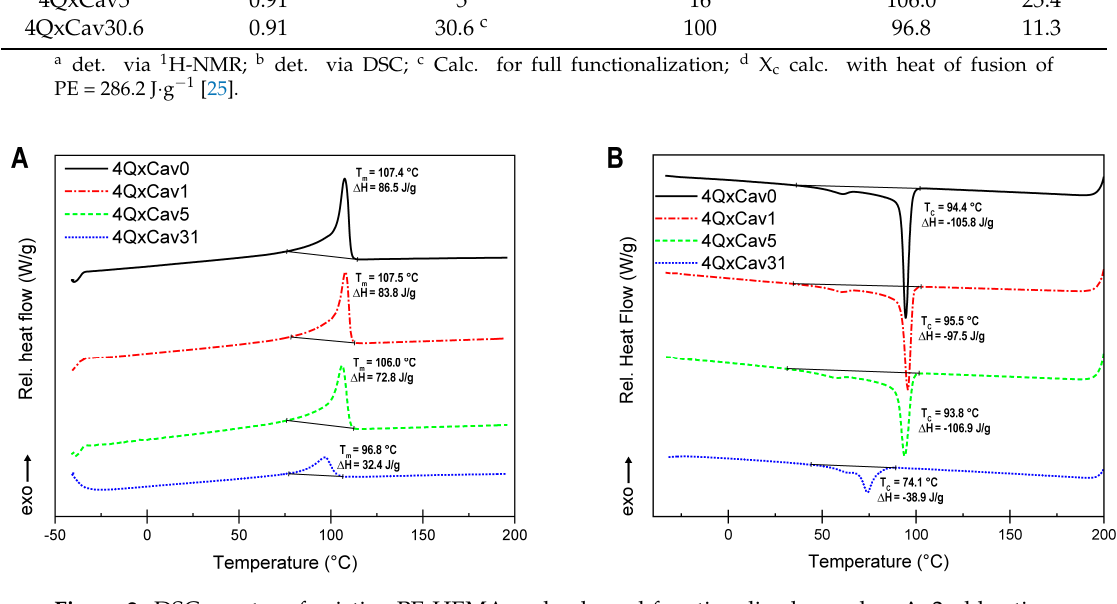
Figure 2. DSC spectra of pristine PE-HEMA and velcrand functionalized samples. A : 2 nd heating ramp, from which it is possible to determine the T m . B : 2 nd cooling ramp from, from which it is possible to determine the T c .